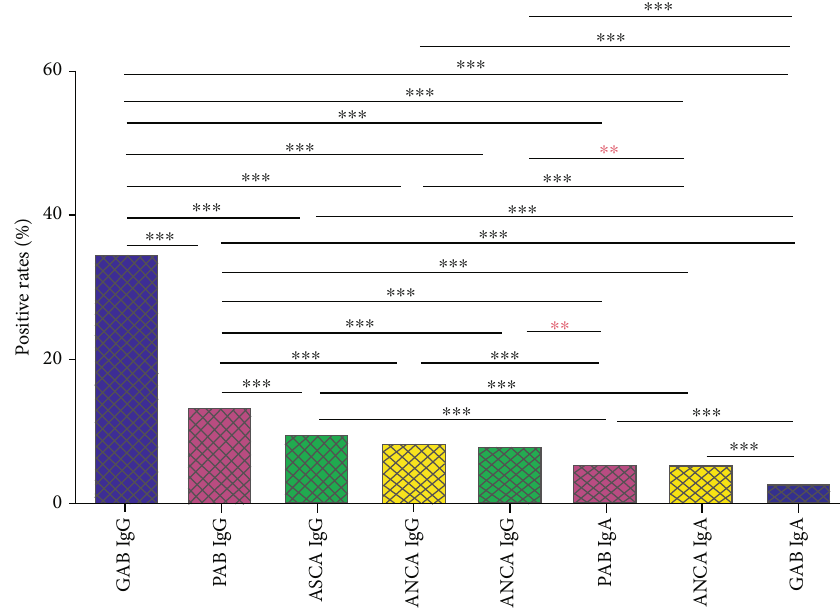
Figure 1: Positive rate of ASCA, GAB, PAB, and ANCA in patients with IBD. Positive rate was presented as percentage and calculated by using McNemar ’ s test. ASCA: anti- Saccharomyces cerevisiae antibodies; GAB: anti-intestinal goblet cell antibodies; PAB: antibodies to exocrine pancreas; ANCA: anti-neutrophil cytoplasmic antibodies; IBD: in fl ammatory bowel disease; ∗∗∗ P < 0 : 0001 ; ∗∗ P < 0 : 001 . Table 2: Ages of ASCA, GAB, PAB, and ANCA in patients with IBD.